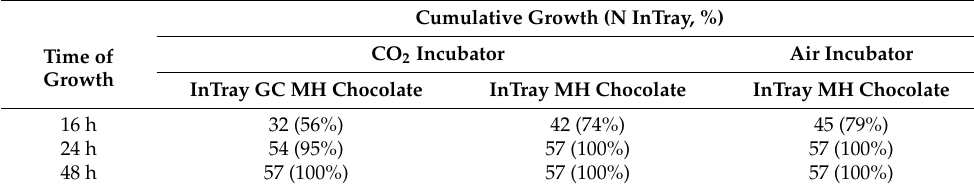
Table A1. Cumulative growth of all strains on InTray Chocolate Agar at different times of growth (N = 19).